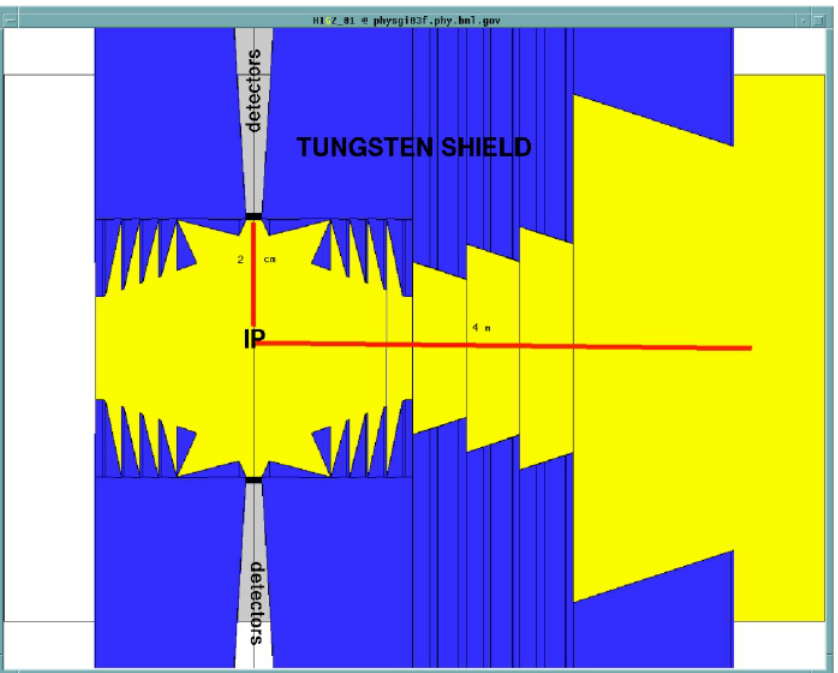
FIG. 64. (Color) Detail of the tungsten shielding designed for the 50 1 50 GeV case. It is designed so that the detector is not connected by a straight line with any surface hit by decay electrons in forward or backward directions. The picture extends out to a radius of 6 cm and, on the right, to a distance 4 m from the IP. The dipole from 2.5–4.0 m is not shown.